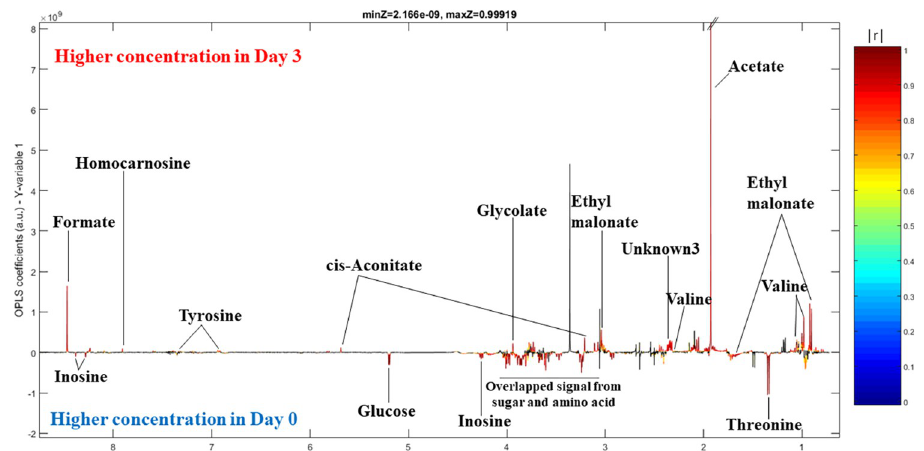
Fig 5. O-PLS-DA loading plots displaying significantly changes in SPMAP09 strain after crystallization in AU observed at day 0 and day 3.